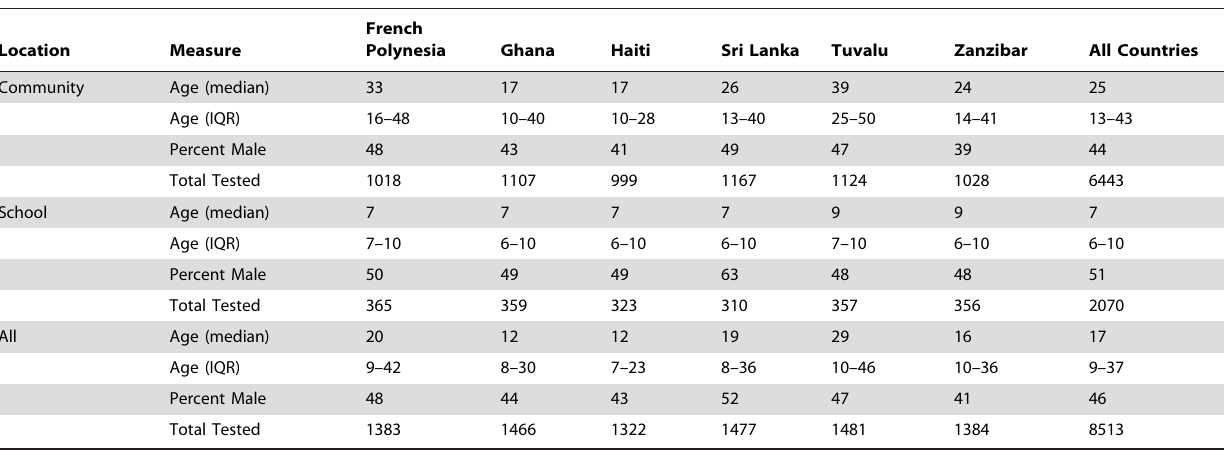
Table 3. Demographic information by country and survey